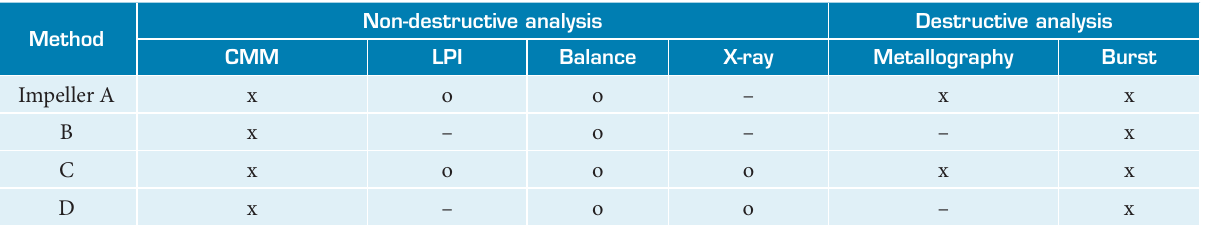
Table 2. Summary of applied examination